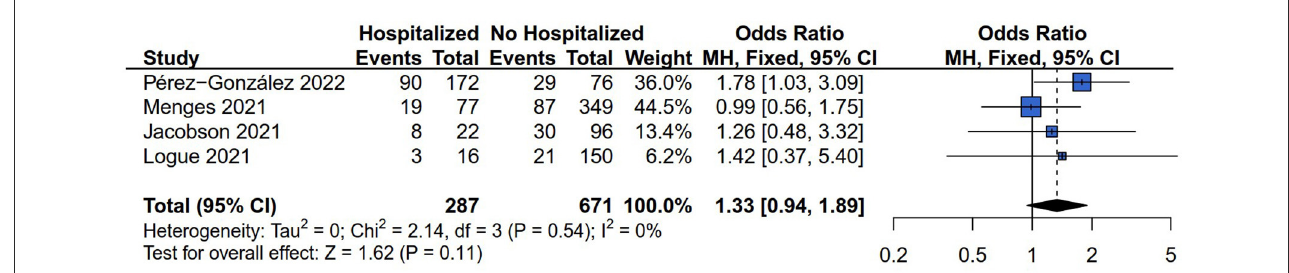
FIGURE2 Forest plot for meta-analysis of any persistent symptom risk among Hospitalized vs. non-hospitalized COVID-19 survivors.